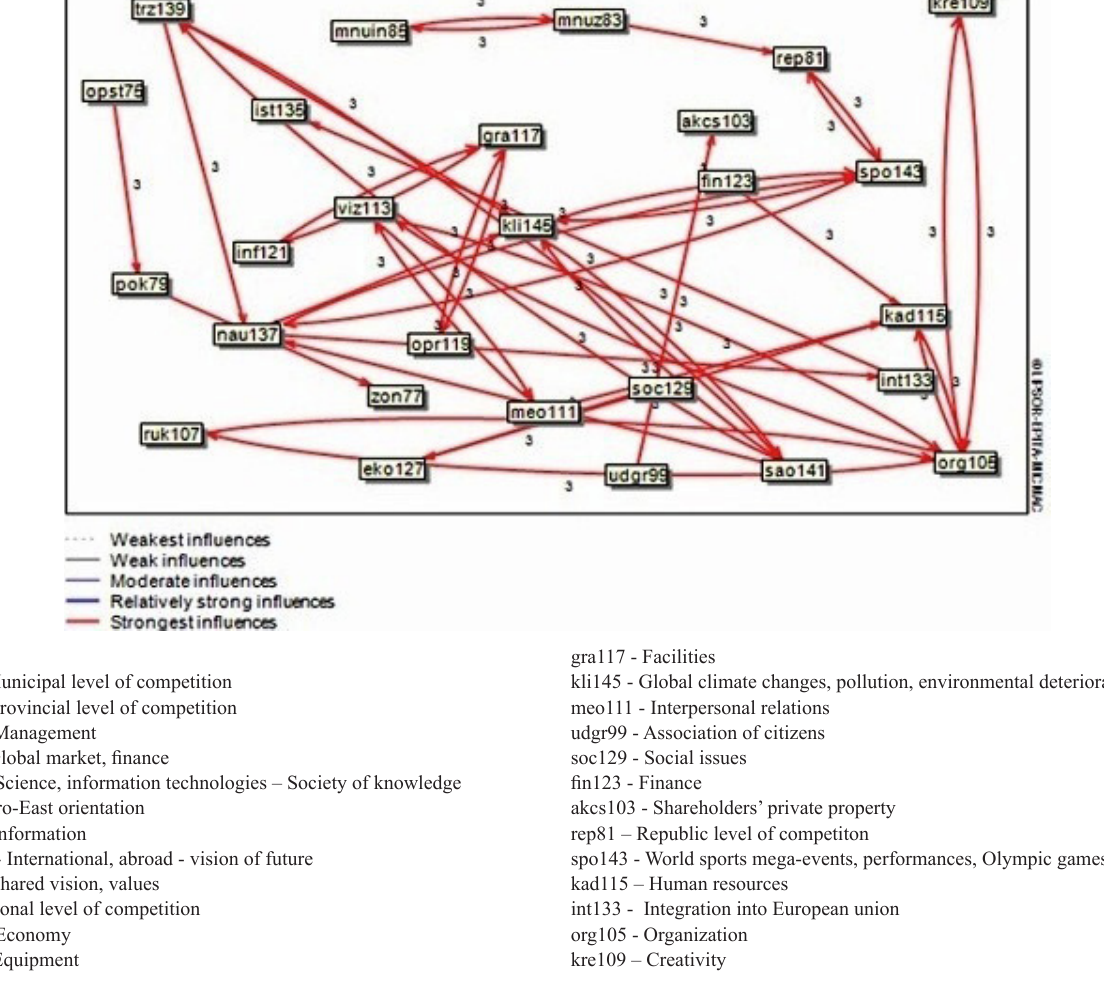
Figure 2. Control sample of respondents – direct